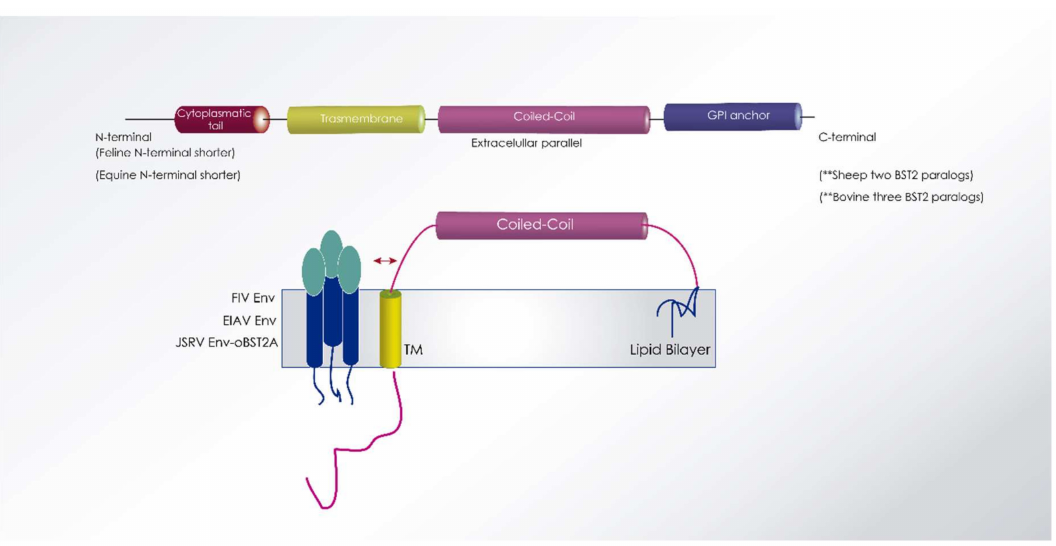
Figure 7. BST2/tetherin protein structure representation including animal lentiviruses targeted species. Cytoplasmatic tail, transmembrane, coiled-coil, and GPI anchor domains are represented. The N-terminal cytoplasmatic tail of feline and equine tetherin is characterized by a shorter region compared to other species. Sheep and bovine tetherin have two and three paralogs, respectively, which inhibit virus infectivity by different mechanisms